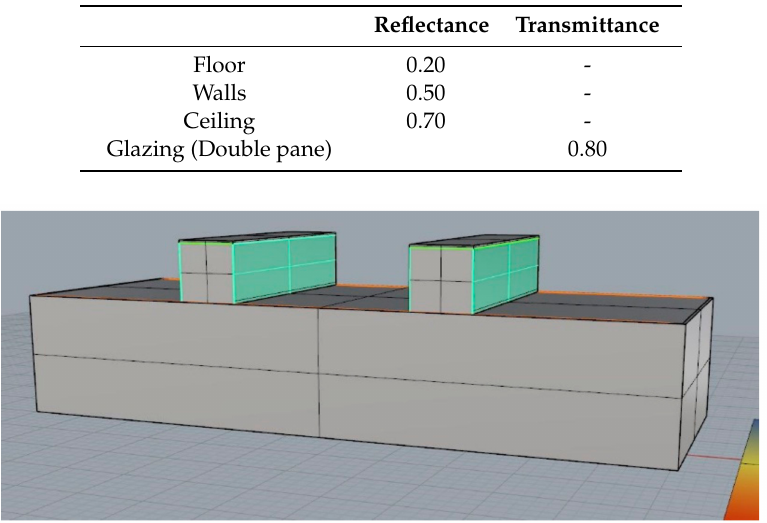
Figure 4. Monitor roof typical arrangement.